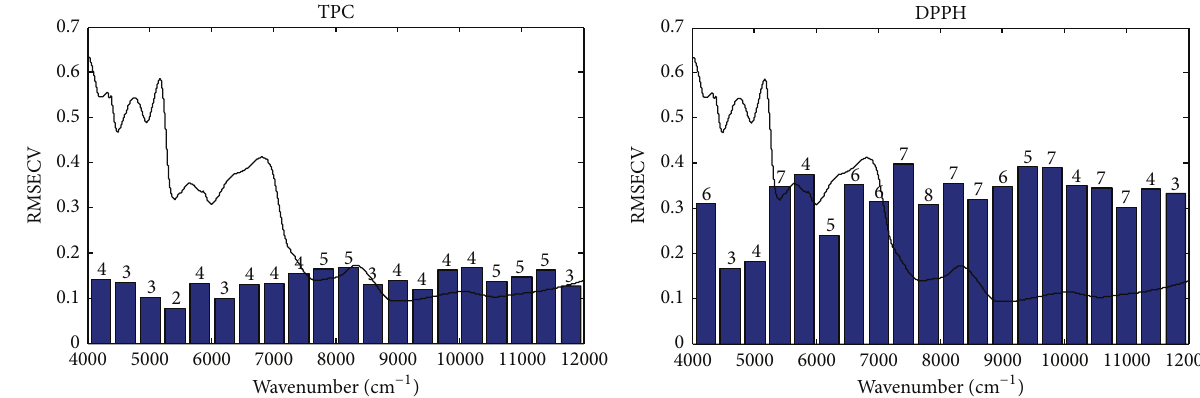
Figure 2: Root mean squared errors of cross-validation (RMSECV) obtained for each spectral interval by interval partial least squares (iPLS) with standard normal variate (SNV). The number at each bar indicates the number of PLS components at each wavelength